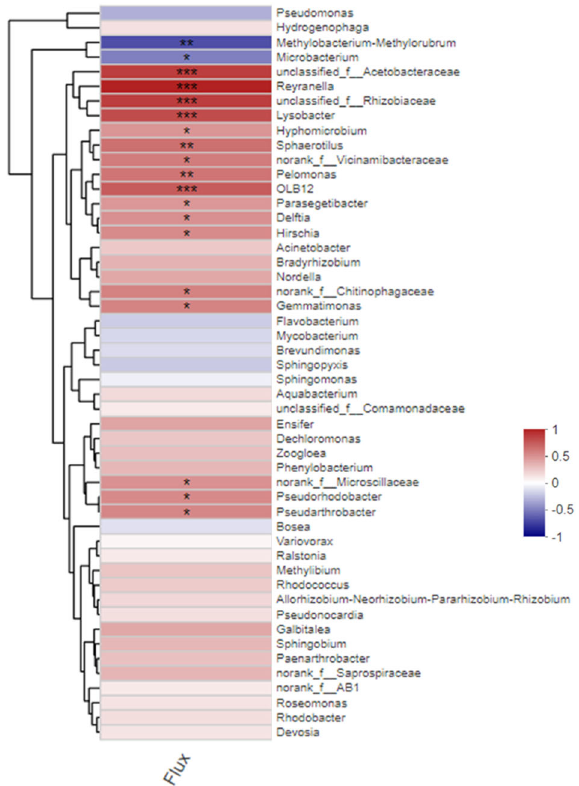
Fig. 6 The correlation between the normalised fl ux of and relative abundance of the top 50 genera. Heat maps shows the correlation coef fi cient between normalised fl ux and relative abundance of the top 50 genera. The p value was generated by Pearson correlation analysis (* p < 0.1, ** p < 0.05, *** p < 0.01). The colour indicated the correlation coef fi cient (dark red: 1, dark blue: − 1).